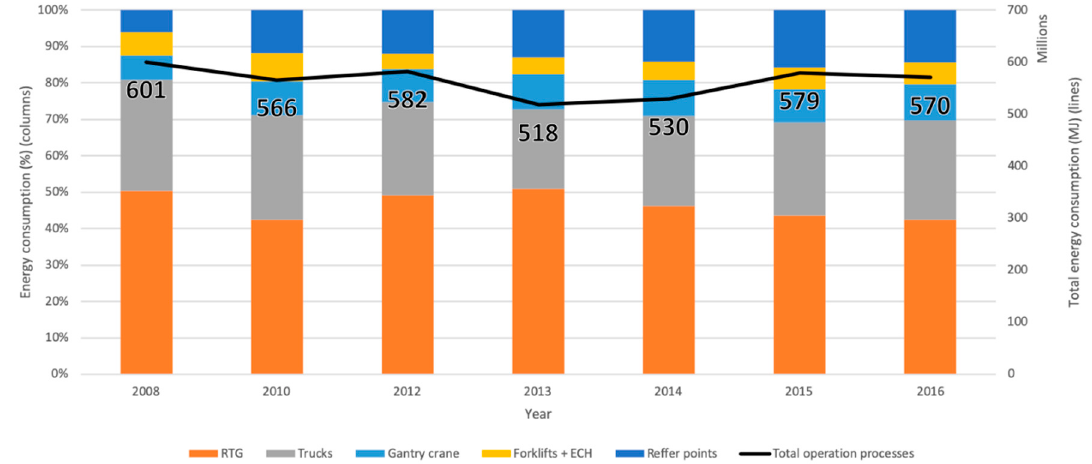
Figure 4. Energy consumption by type of machine 2008–2016.